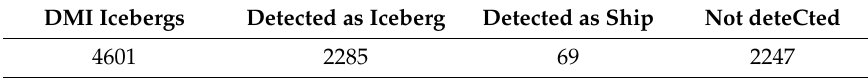
Figure 7. 20 April 2020. Close-up detection examples, left images show validation iceberg polygons from DMI and right images show model detections. Blue marks are iceberg detections, and red marks are ship detections. Table 3. 18 April 2020. Validation overview. Table 3. April 18, 2020. Validation overview.